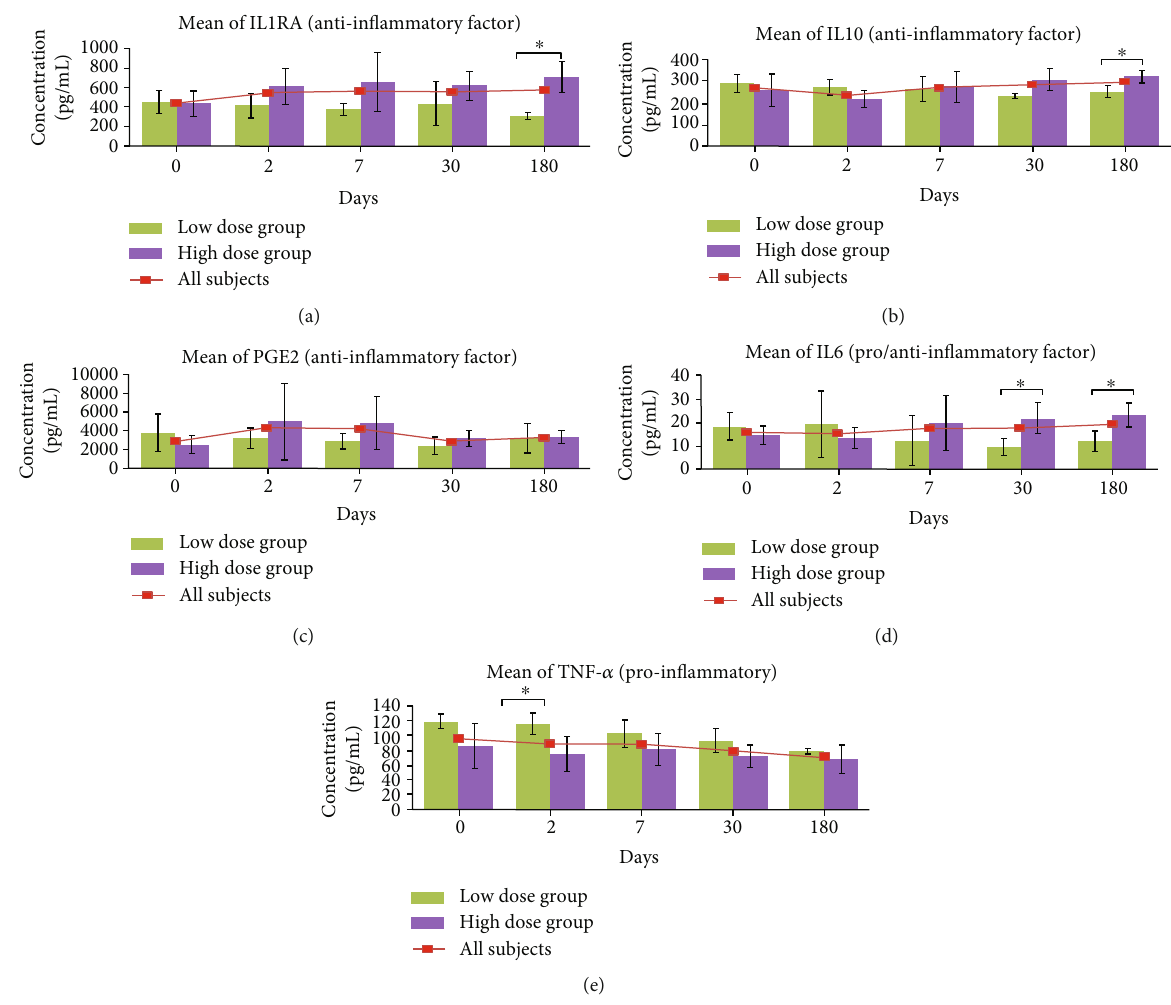
Figure 2: Evaluation of serum levels of cytokines, IL-1RA, IL-10, PGE2, IL-6, and TNF- α , for subjects between LD and HD group. Only serum levels of cytokines IL-1RA, IL-10, IL-6, and TNF- α were found to have signi fi cant changes between both groups. Statistical signi fi cance of biomarkers between LD and HD groups were assessed by using the Mann – Whitney test. ∗ Signi fi cant value at p < 0 : 05